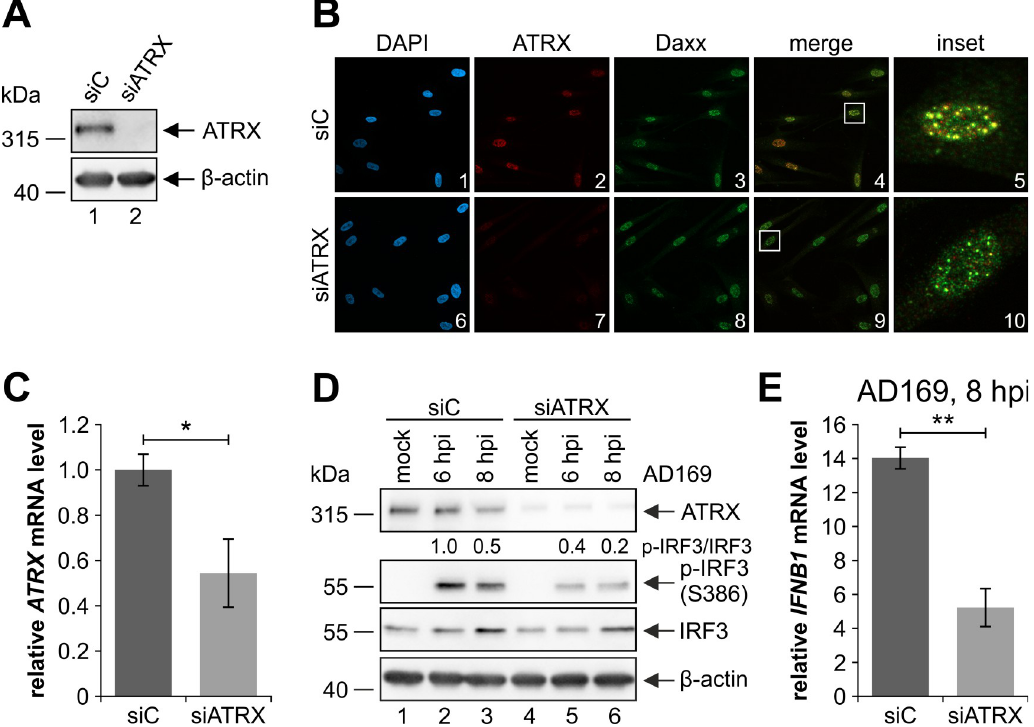
Fig 1. Suppressed innate immune response to HCMV infection in ATRX knockdown HFFs. (A) ATRX knockdown efficiency in siATRX cells was assessed by Western blotting; β -actin served as an internal loading control. (B) For further characterization of the siATRX cells, ATRX and its interaction partner Daxx were immunostained. 4’,6-diamidino-2-phenylindole (DAPI) was counterstained to visualize cellular nuclei. (C) To determine ATRX mRNA levels, total RNAs were isolated from ATRX knockdown HFFs (siATRX) and respective control HFFs (siC) and RT-qPCR was performed. (D+E) ATRX knockdown HFFs and respective control HFFs were either mock-infected or infected with the laboratory HCMV strain AD169 (MOI of 1). (D) At 6 and 8 hpi, cells were harvested for Western blot analyses to determine IRF3 phosphorylation; β -actin served as an internal loading control. Signal intensities were quantified relative to infected siC cells at 6 hpi (lane 2). (E) Additionally, total RNAs were isolated at 8 hpi and RT-qPCR was performed to determine IFNB1 induction. (C+E) Depicted values were calculated from triplicates relative to (C) untreated or (E) mock-infected siC cells using GAPDH as a housekeeping gene and are shown as mean ± SD. One out of (C) four or (E) two independent experiments is shown. Statistical analysis was performed with respective Δ Cq-values using a student’s t -test (unpaired, two-tailed); � p < 0.05, �� p < 0.01. (A+B+D) The following antibodies were used: (A+D) anti-ATRX (39-f), anti- β -actin (AC-15); (D) anti-phospho-IRF3 (Ser386) (EPR2346), anti-IRF3 (D6I4C); (B) anti-ATRX (D-5), anti-Daxx